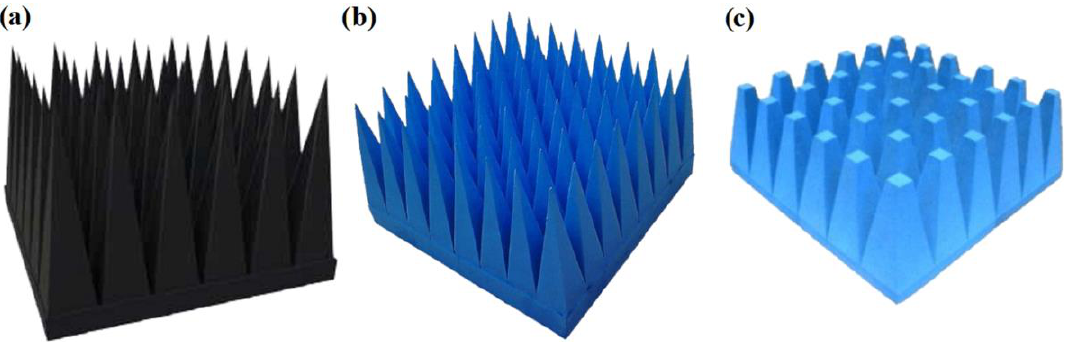
Figure 5. Pyramidal foam absorbers [80]: ( a ) type 5796, ( b ) type 3680 and ( c ) type 3660.